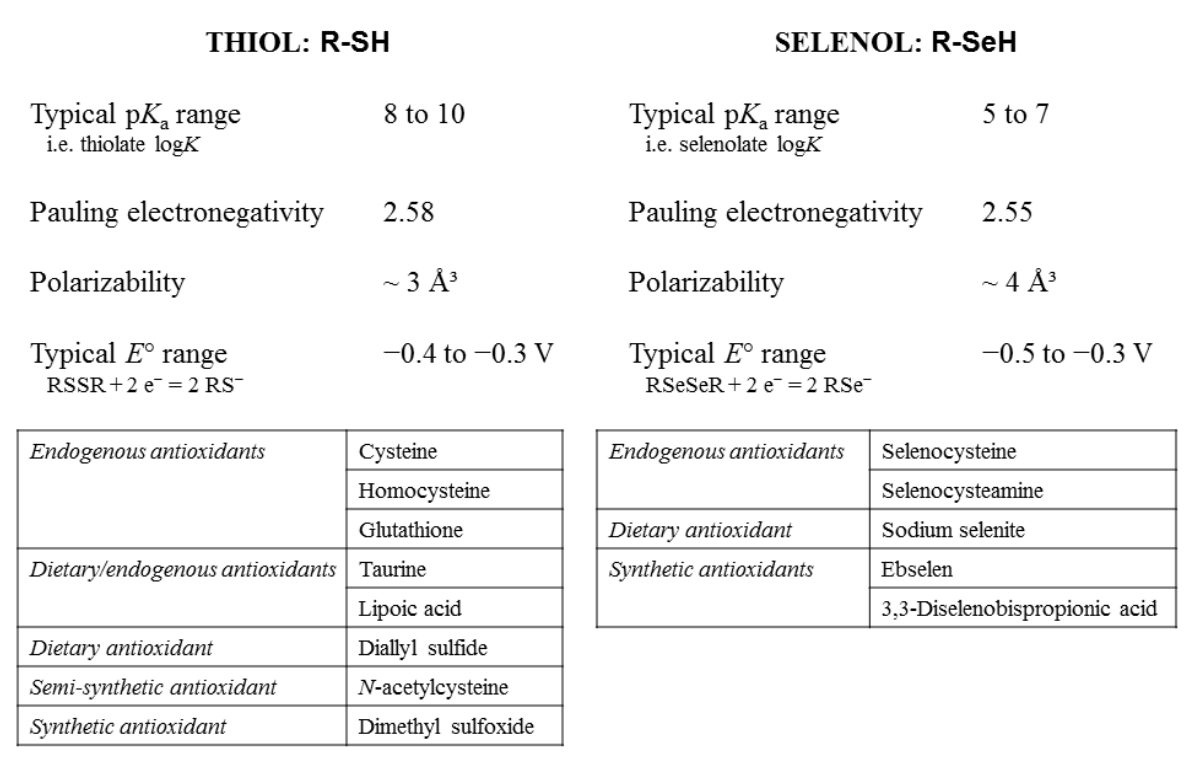
Figure 2. Some general physico-chemical properties of sulfur and selenium in thiol and selenol moieties, together with some examples of sulfur- and selenium-containing antioxidants (not necessarily con fi ned to thiol/selenol-containing ones).